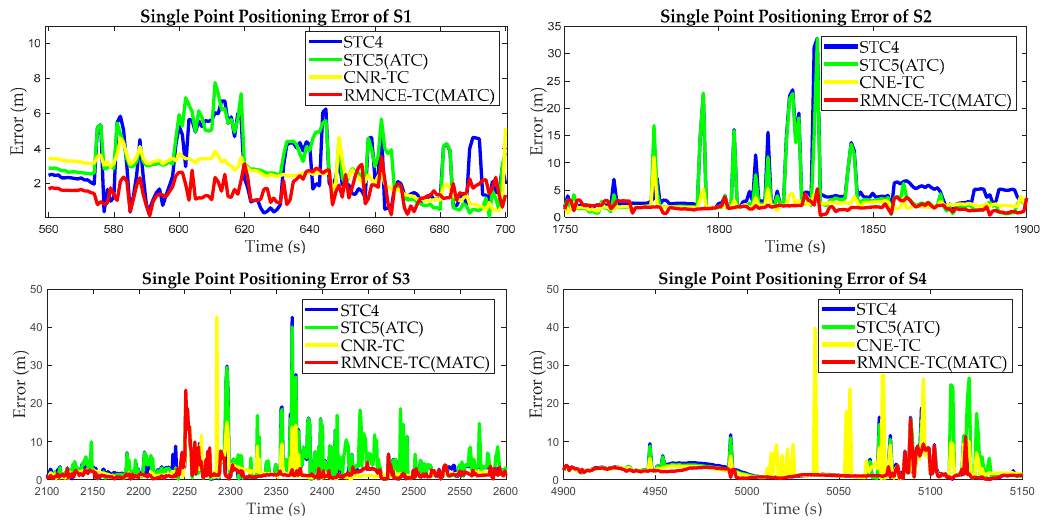
Figure 19. Single point positioning errors of the different satellite selection algorithms during segments